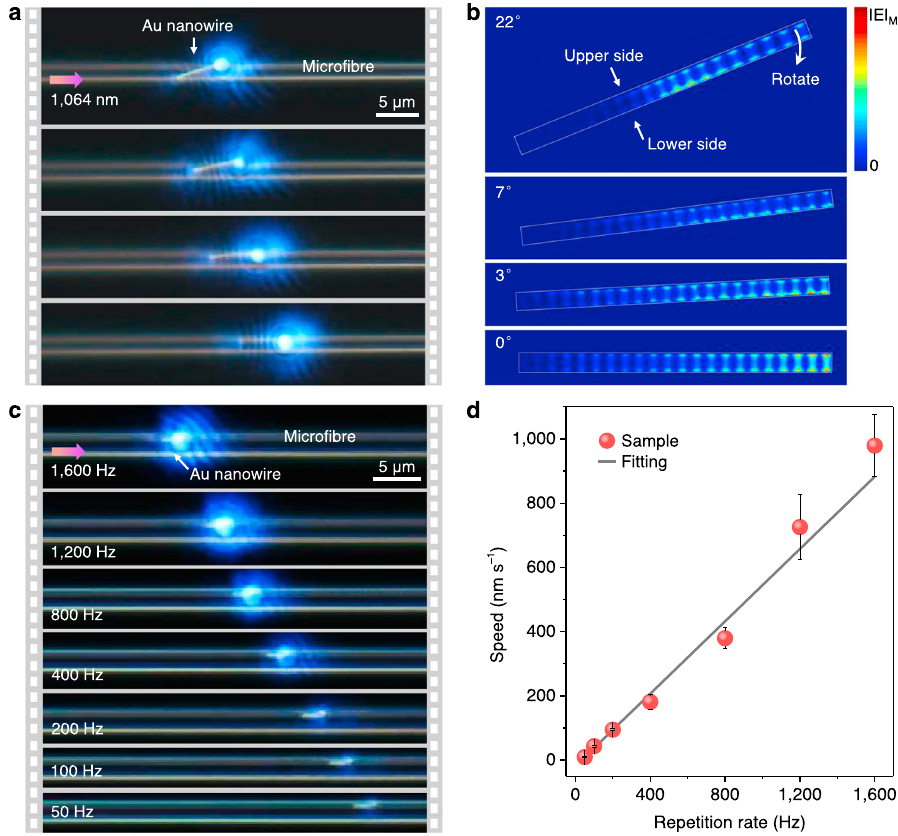
Fig. 4 Controlling manipulations of Au nanowires on micro fi bres. a Sequencing photographs of an Au nanowire ( L NW = 6.3 μ m) tilted on a suspended micro fi bre ( D fi ber = 2.1 μ m) gradually rotating to the parallel position, driven by the 1064 nm laser with average power of 6 μ W. b Simulated heat power density distribution on the nanowire bottom with different tilted angles of 22, 7, 3, and 0°. c Sequencing photographs of an Au nanowire ( L NW = 2.3 μ m) moving on a suspended micro fi bre ( D fi ber = 2.2 μ m) as decreasing the laser repetition rates from 1600 to 50 Hz, during which each pulse energy remained constant at 8.6 nJ. d Dependence of the moving speed of the nanowire on the laser repetition rates. Error bars are the variance of the moving